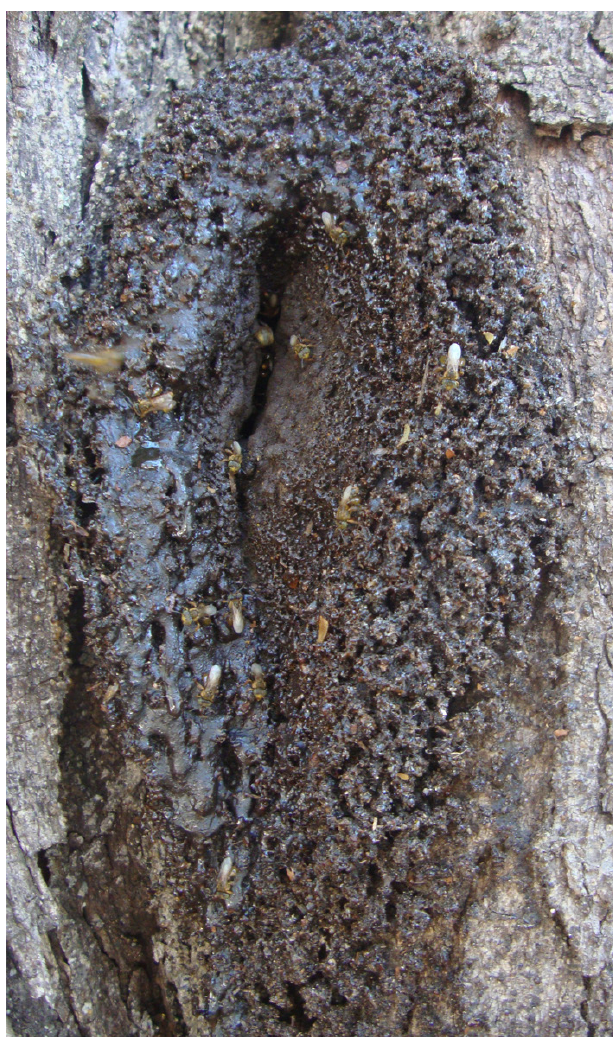
Fig 3 . Nest entrance of Tetragona clavipes . (Photo: Ivan de Castro)